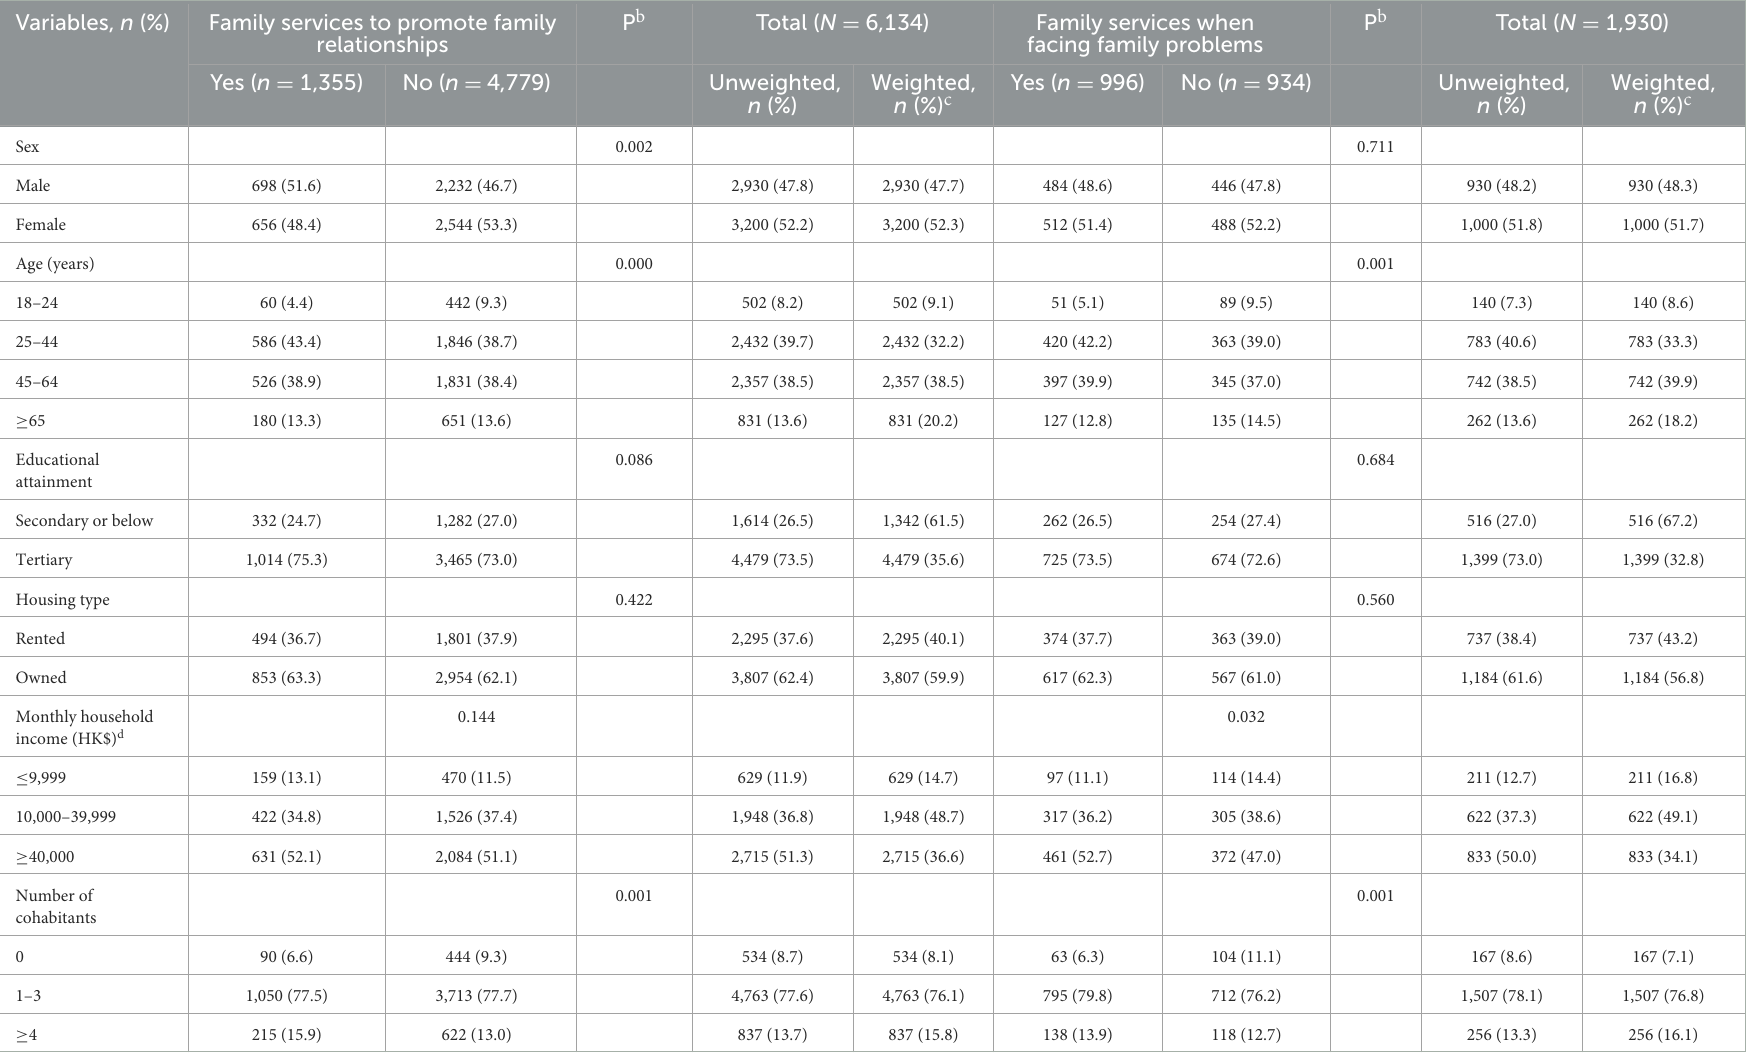
TABLE 1 Sociodemographic characteristics, family wellbeing, and family communication quality by willingness to attend family services via face-to-face or online means a